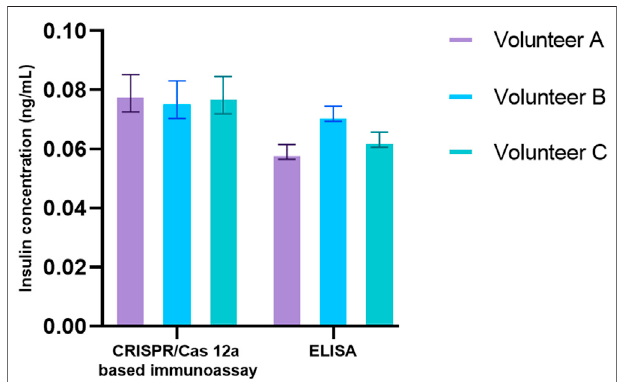
FIGURE 6 | Detection of salivary insulin from volunteers both by a CRISPR/Cas12a-assisted new immunoassay (CANi). The antibody pair #1 and triggering ssDNA 1, and guiding RNA 1 were used in the